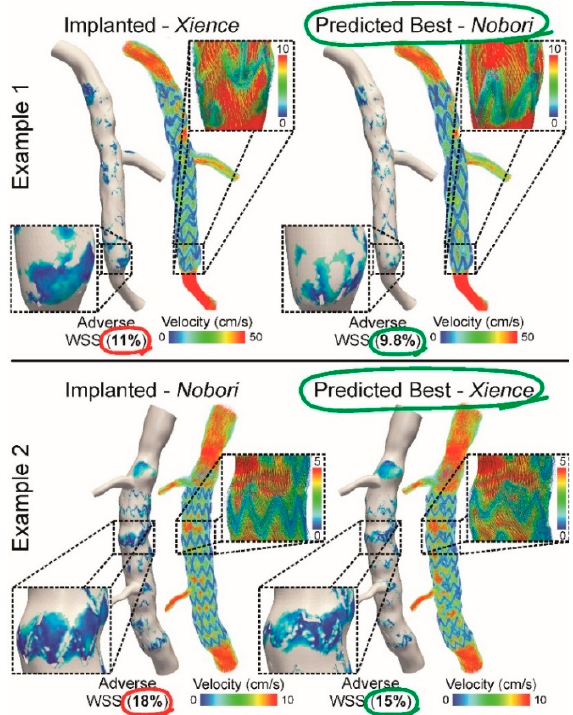
Figure 5. CFD simulations showing the amount of adverse WSS and near-wall velocity for two patients who may not have received the optimal DES according to CFD. Red circled percentages underscore more adverse areas of low WSS relative to green circled percentages for each example. These examples reveal how geometric perturbations for a given patient can factor into adverse WSS and may correlate with